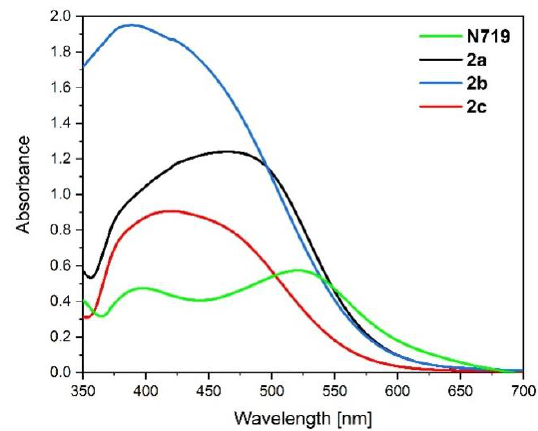
Figure 6. UV-Vis spectra of anchored dyes 2a–2c and N719 on TiO 2 .